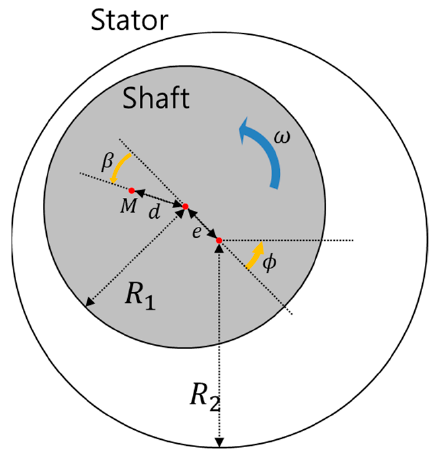
Figure 16. Description of the unbalanced mass center 𝛽 can be obtained by using Equation (15) [22].